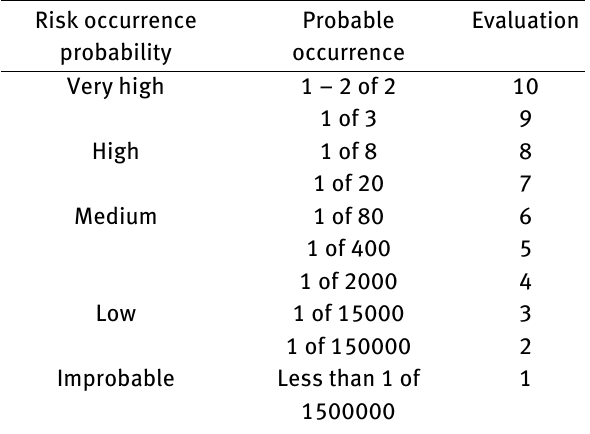
Table 4: Modified risk occurrence cause evaluation (Source: In-